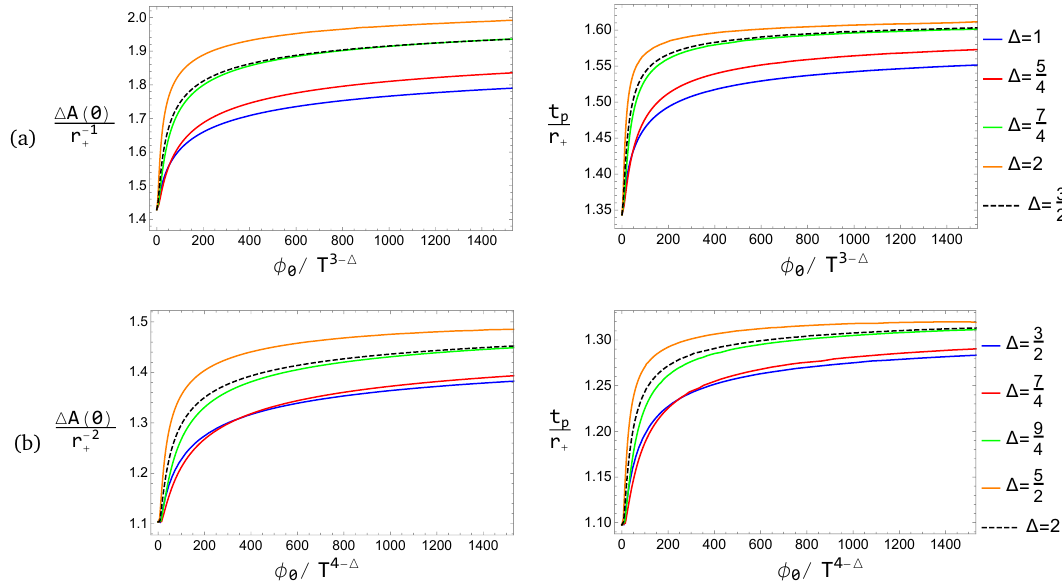
Figure 10: The initial area difference ∆ A ( 0 ) and the Page time t / T d − ∆ for (a) d = 3 and (b) d = 4, all for various ∆ . The axes are in r of φ 0